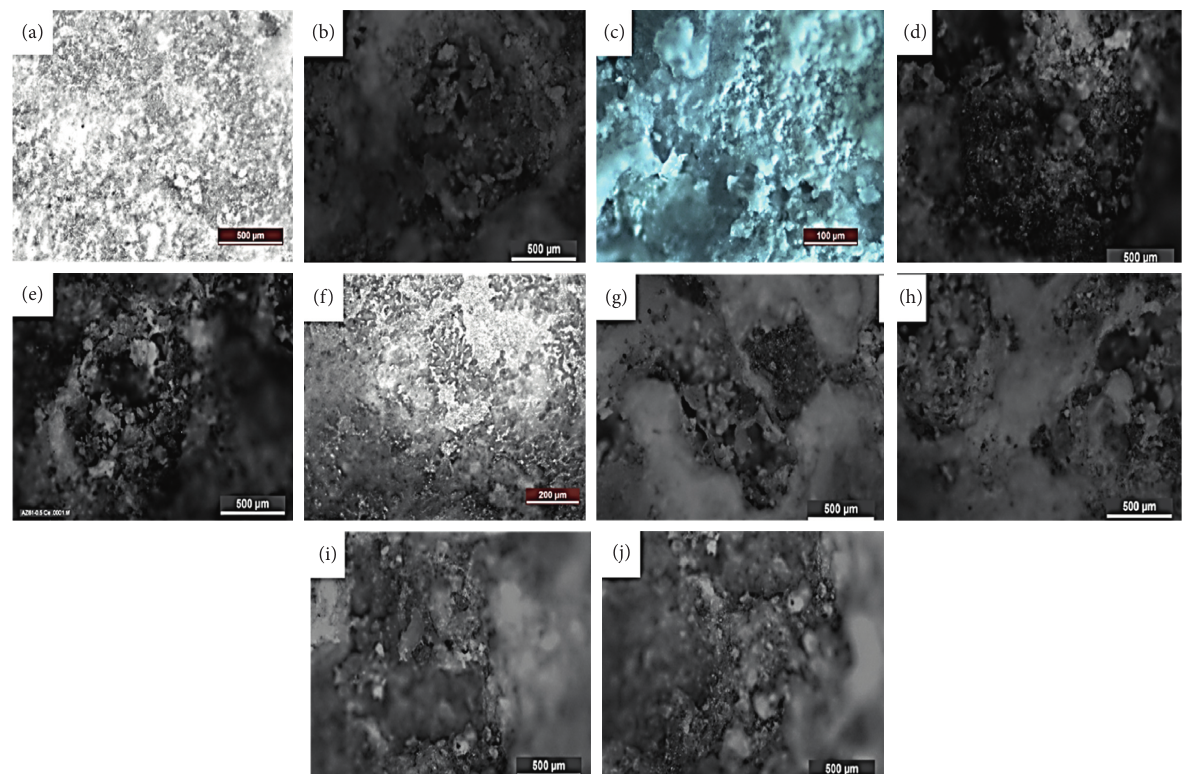
Figure 10: Microstructures after immersion test in 3.4wt.% NaCl solution.